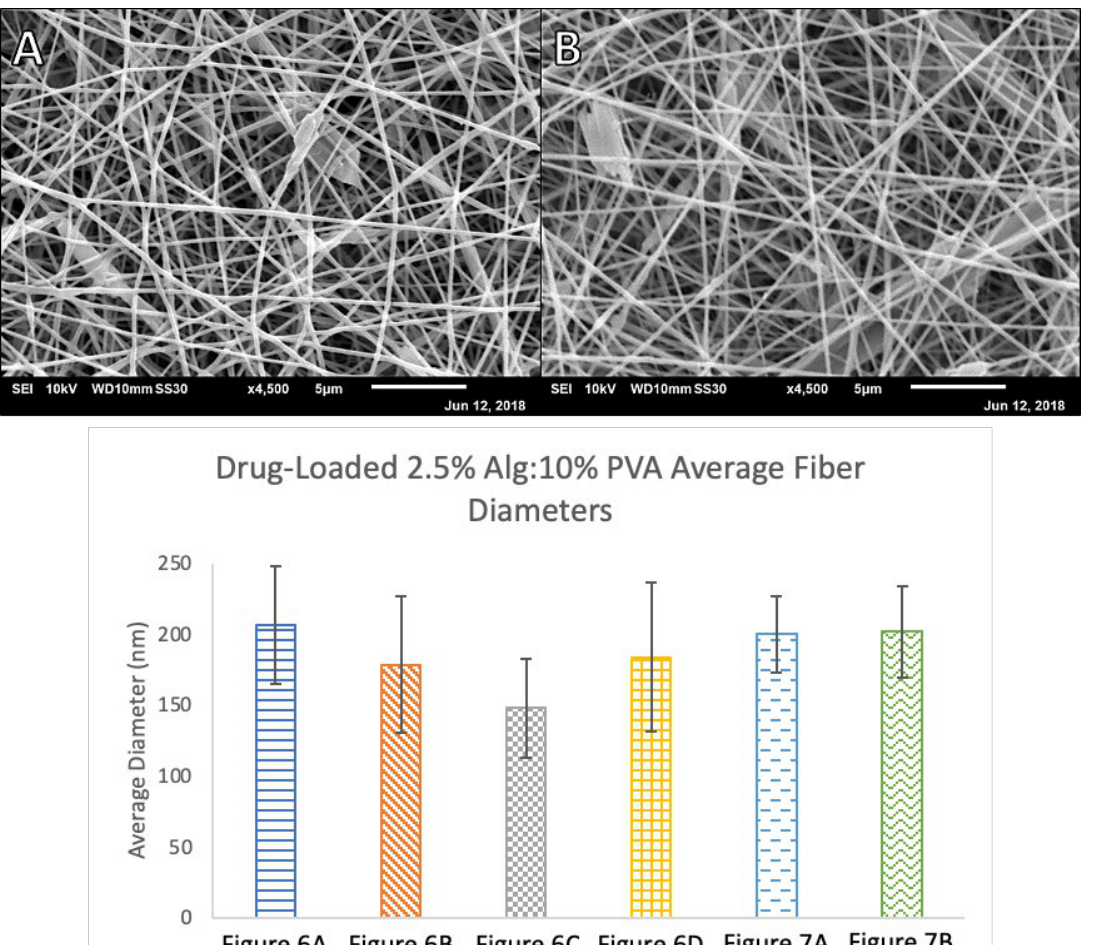
Figure 7. Top: SEM micrographs of lower-concentration drug-loaded 3:7 2.5% Alg:10% PVA nano- fibers at 5.8 μL/min, 150 mm, 21 kV, and 1 mL disp. ( A ) 3.5% Cipro and ( B ) 3% Cipro. Bottom: Comparison of average drug-loaded 2.5% Alg:10% PVA fiber diameters, n = 40. Each label corre- sponds to the referenced fiber formulation and spinning conditions described for the micrograph image of the fibers. All fibers are 3:7 2.5% Alg:10% PVA. Figure 6A 5% Cipro at 7.5 μL/min, 100 mm, 19 kV; Figure 6B 5% Cipro at 9.8 μL/min, 100 mm, 20 kV; Figure 6C 4% Cipro at 7.5 μL/min, 100 mm, 20 kV; Figure 6D 4% Cipro at 9.8 μL/min, 100 mm, 15 kV; Figure 7A 3.5% Cipro at 5.8 μL/min, 150 mm, 21 kV; and Figure 7B 3% Cipro at 5.8 μL/min, 150 mm, 21 kV.